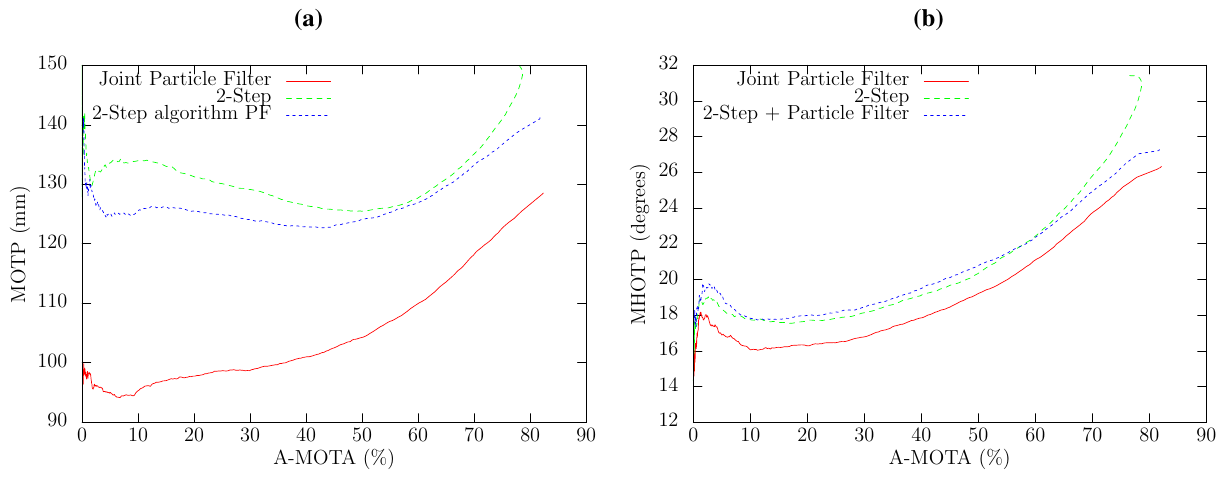
Figure 4. Curve of all possible tracking accuracy (acoustic multiple object tracking accuracy (A-MOTA)), localization tracking precision (multiple object tracking precision (MOTP)) (a) and 3D orientation angle precision (multiple head orientation tracking precision (MHOTP)) (b) results, employing a sweep threshold parameter on the algorithm confidence. (a)